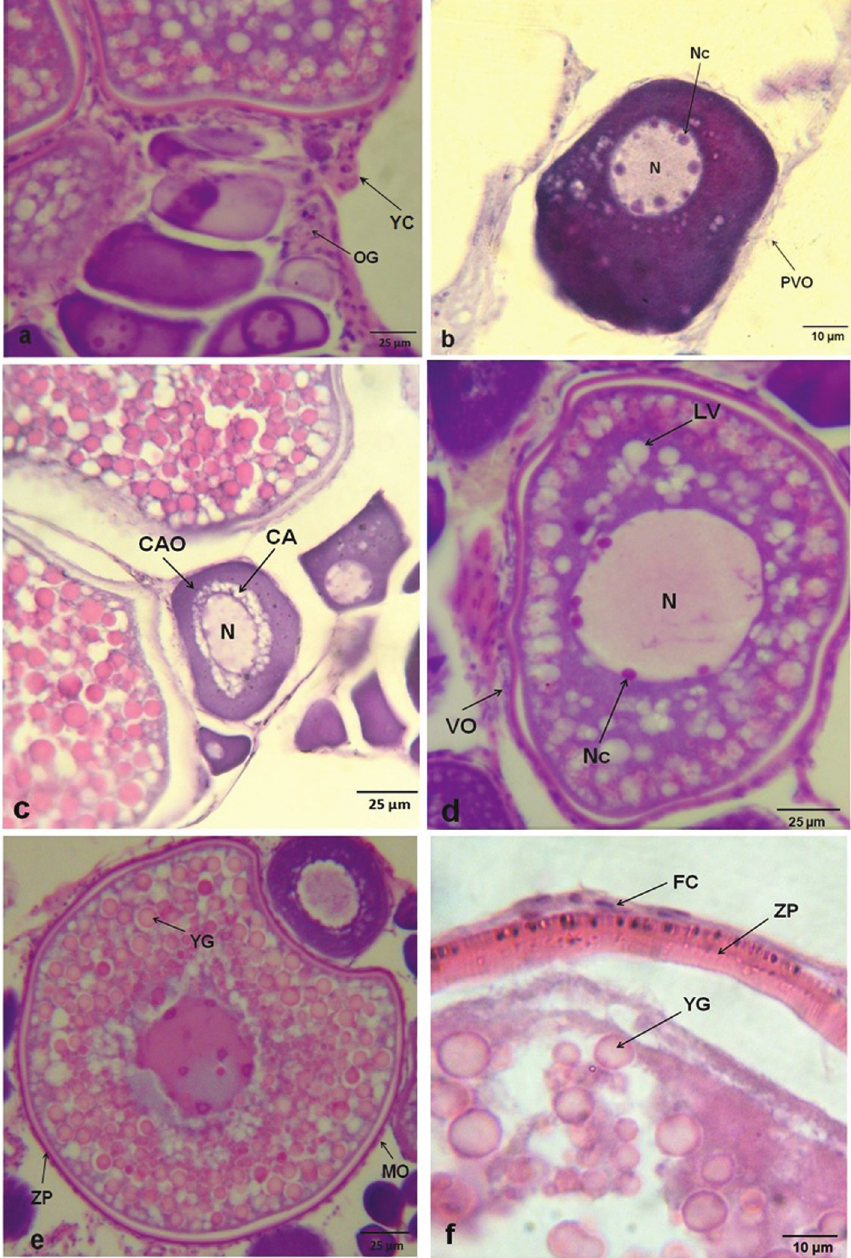
Fig. 2. Photomicrographs of the oogenesis stages of ovaries of black triggerfish caught in the São Pedro e São Paulo Archipelago, between January 2006 and May 2008. ( a ) YC - young cells, oogonia - OG; ( b ) PVO - previtellogenic oocytes; ( c ) CAO - cortical alveoli oocytes; ( d ) VO - vitellogenic oocytes; ( e ) MO - mature oocyte; ( f ) ZP - zona pellucida (radiated). N - nucleus, Nc - nucleolus; FC - follicular cell; LV - lipid vacuole; YG - yolk globules; CA - cortical